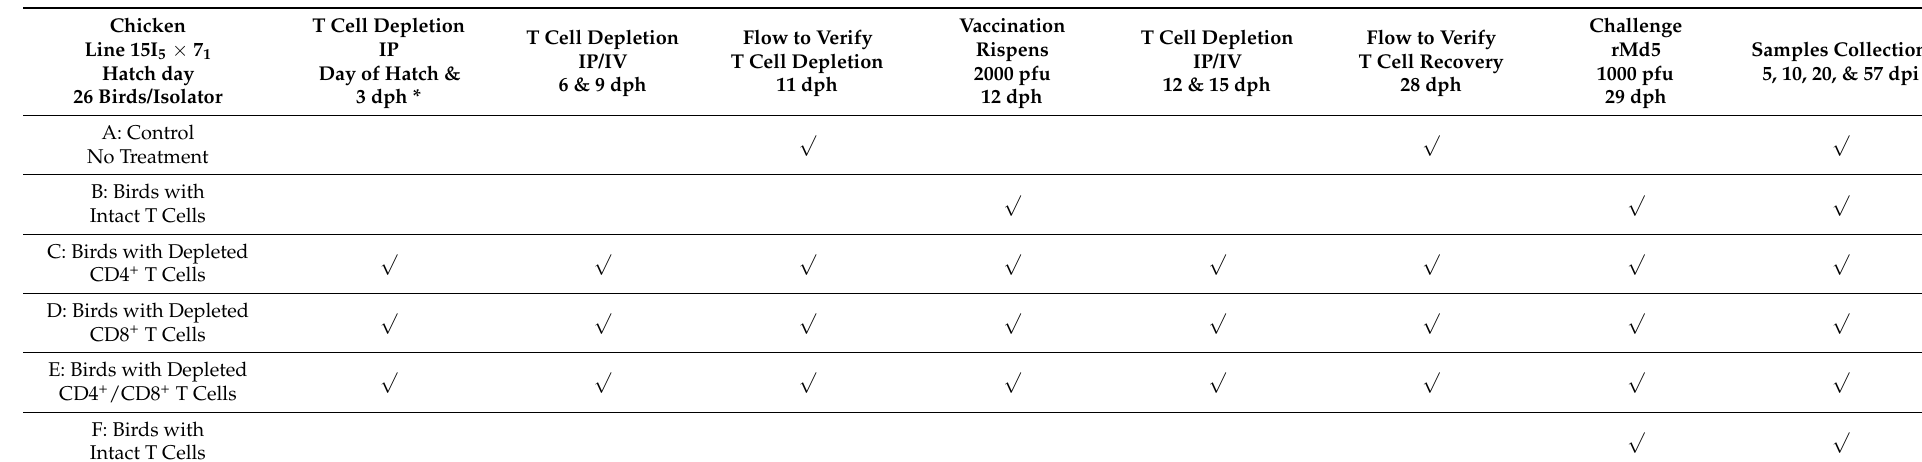
Table 1. T Cell depletion, vaccination, challenge, and tissue sample collection.